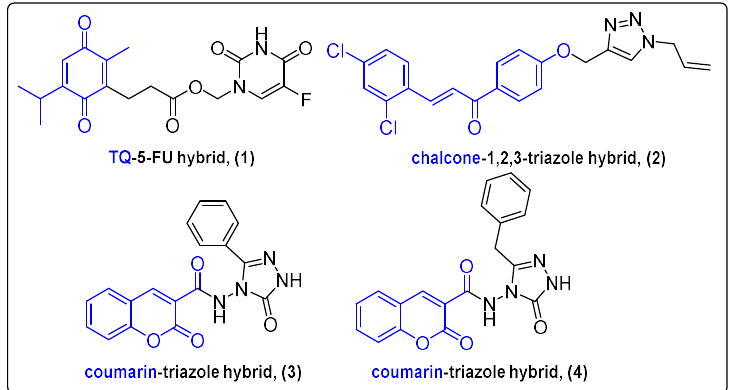
Figure 2. TQ, chalcone and coumarin